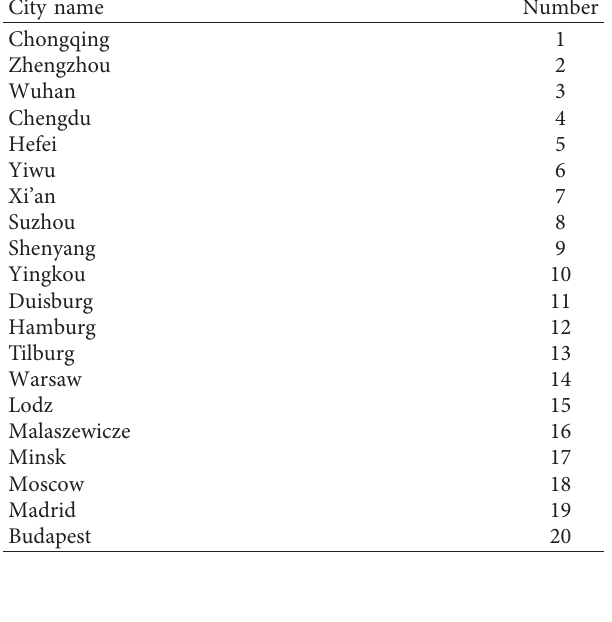
Table 11: Fixed time T